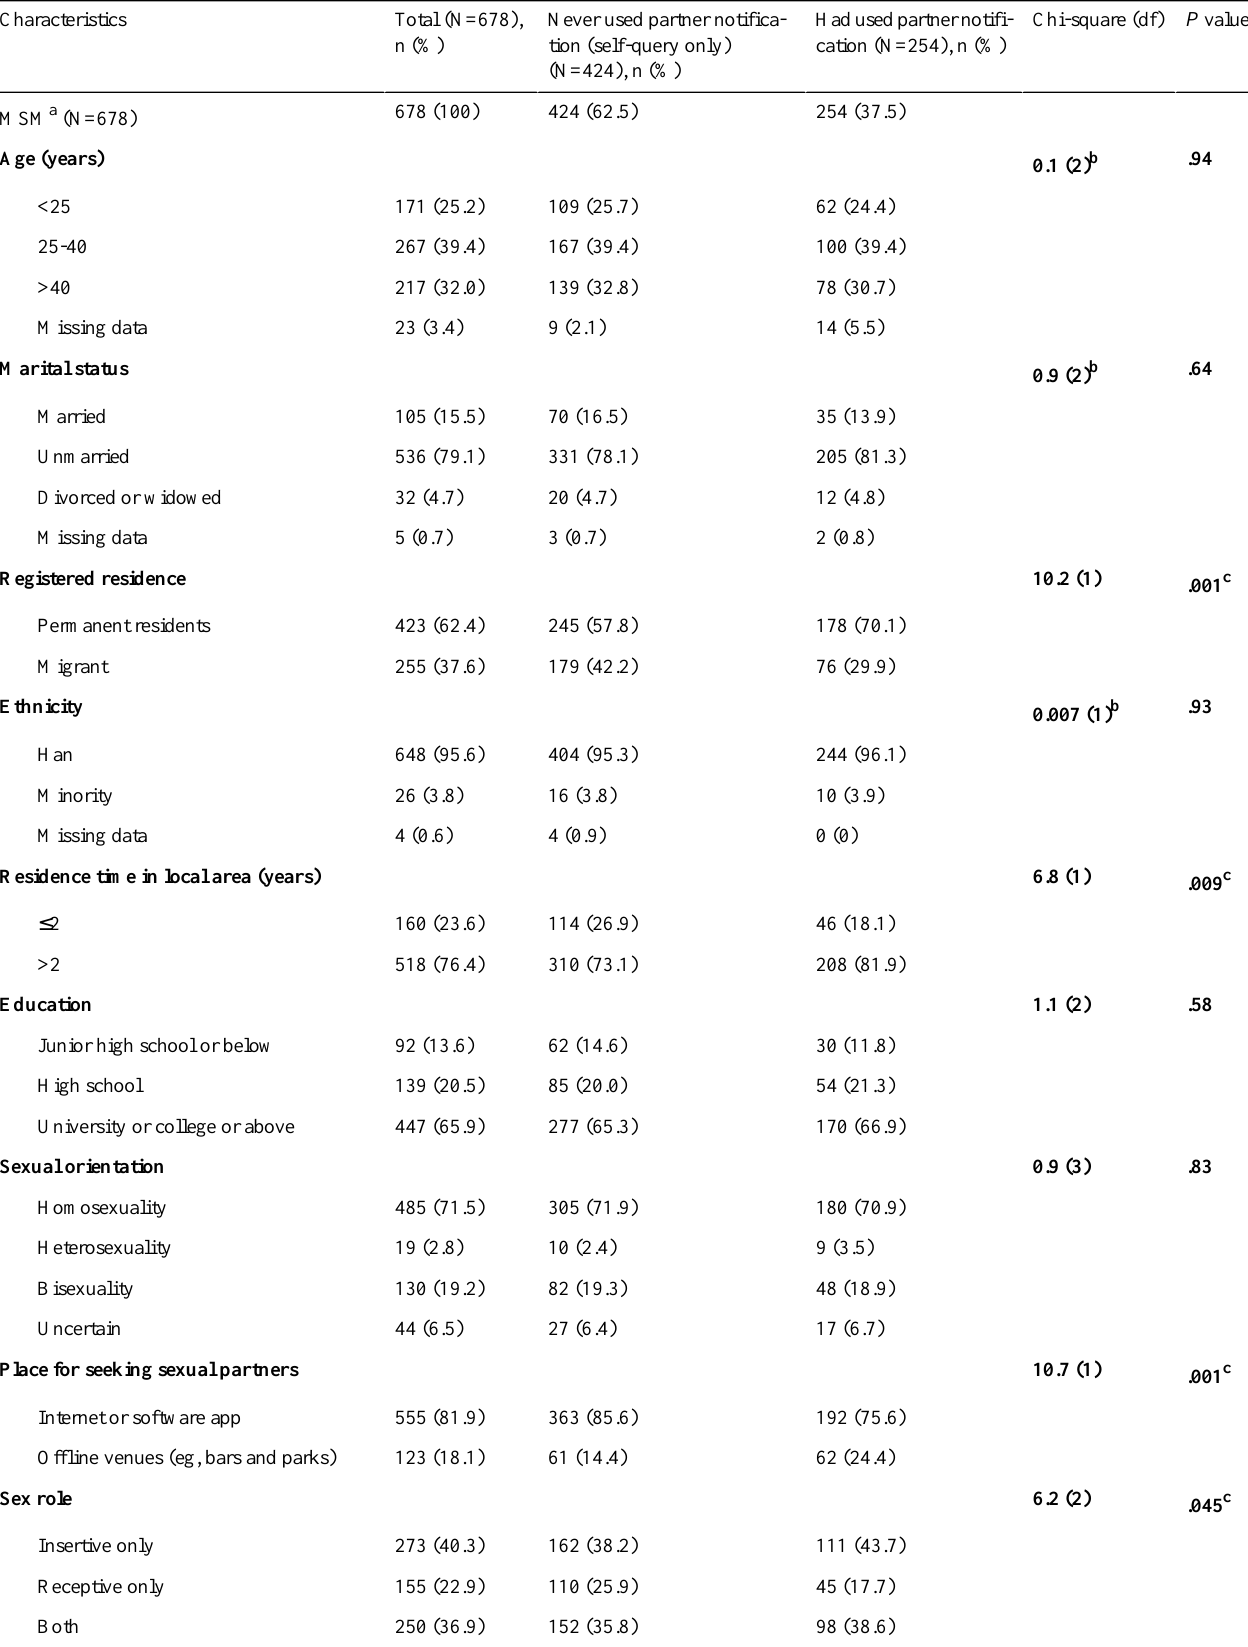
Table 2. Basic characteristics of the app users.